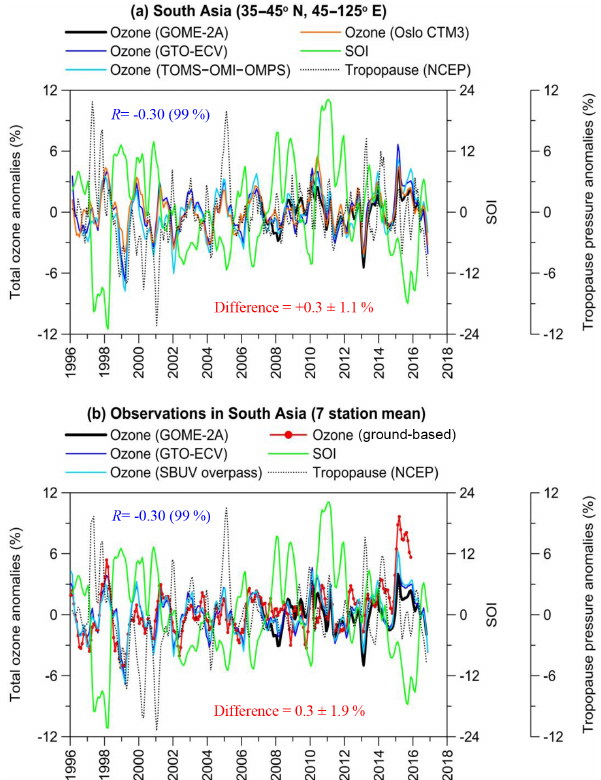
Figure 8. (a) Example of regional time series of total ozone (%) over the southern Pacific region (10–20 ◦ S, 180–220 ◦ E) along with SOI. The dotted line shows the respective tropopause pressure vari- ability from NCEP. R is the correlation coefficient between GTO- ECV total ozone and SOI (statistical significance of R is given in parentheses). The difference refers to the mean difference ± σ (in %) between GTO-ECV and the combined TOMS–OMI–OMPS satellite data; (b) same as in (a) , but for SBUV overpass and GB data at the Samoa station. The difference refers to the mean differ- ence ± σ (in %) between GTO-ECV and GB data.